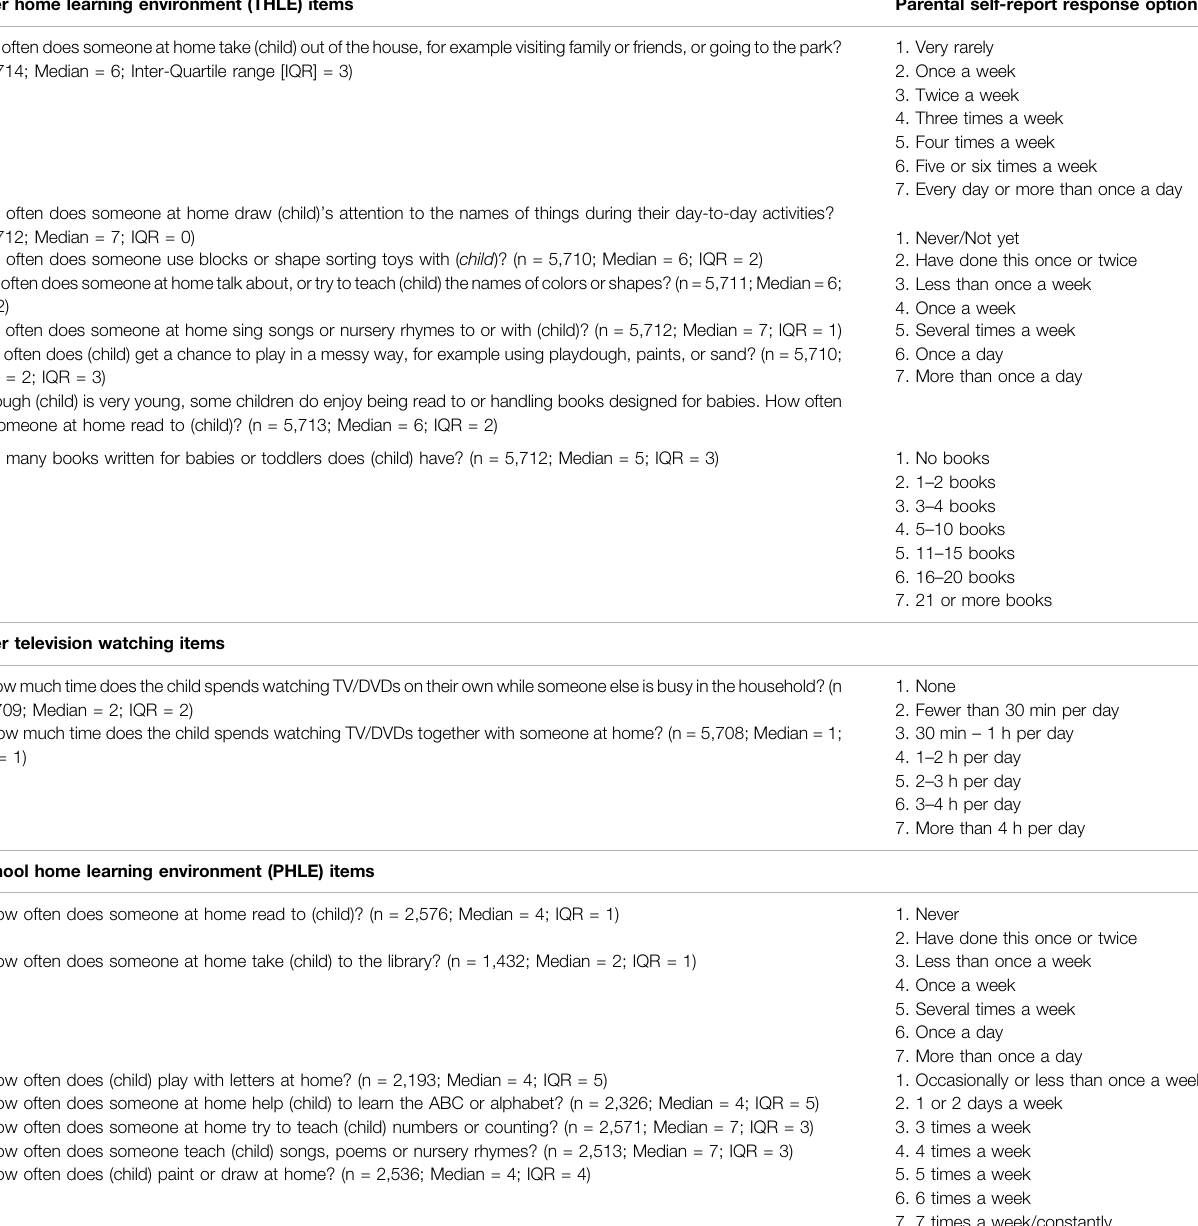
TABLE1| Wording,responseoptions,anddescriptivestatisticsfortheeightitemsdevelopedforpotentialinclusionintheToddlerHomeLearningEnvironment(THLE)scale, the two items relating to toddler television watching, and the seven items included in the Preschool Home Learning Environment (PHLE) scale. Toddler home learning environment (THLE)